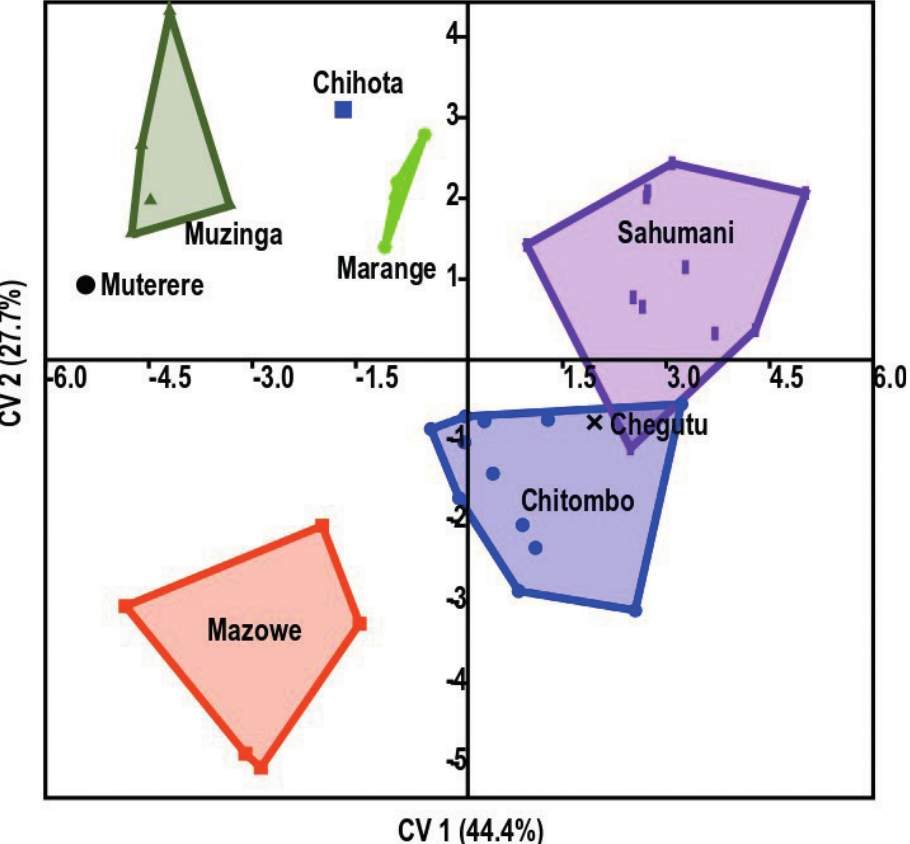
Figure 4. Canonical variate analysis based on the first 15 PC scores of gonopod shape across eight popu- lations of B. flavicollis . Scatterplot indicates population grouping of sampled specimens along CV1 and CV2. Percentages indicate the proportion of variance explained by each CV